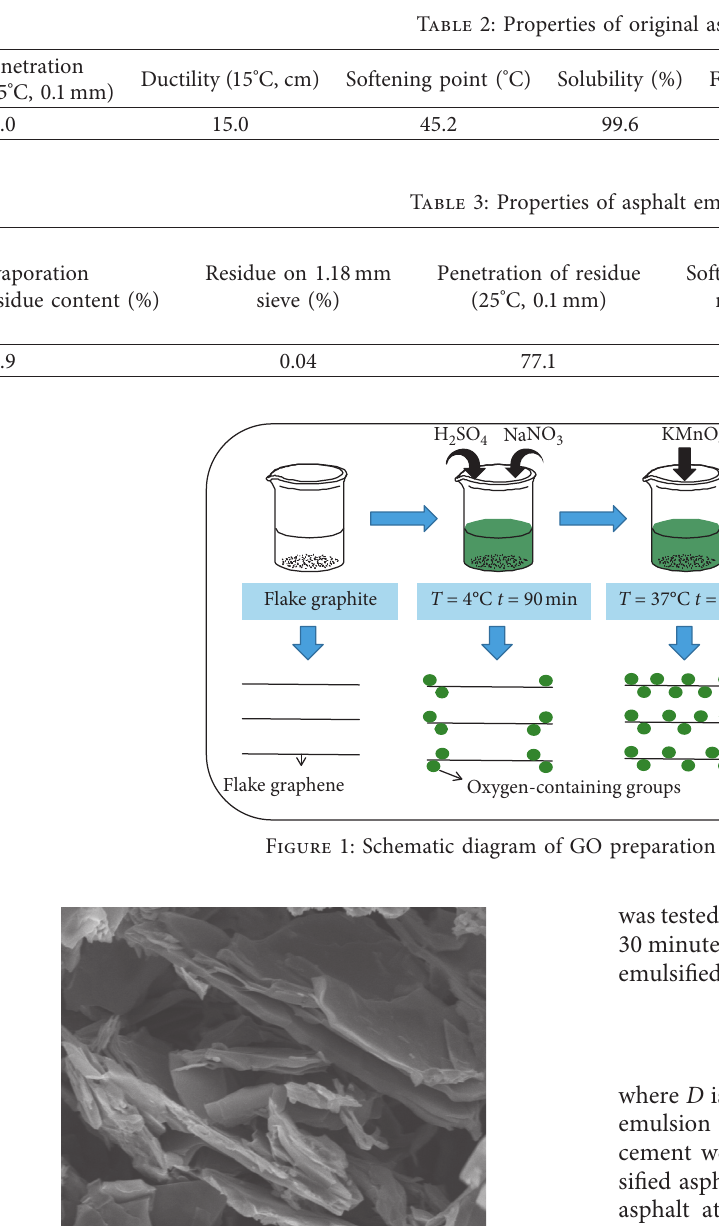
Table 2: Properties of original asphalt.